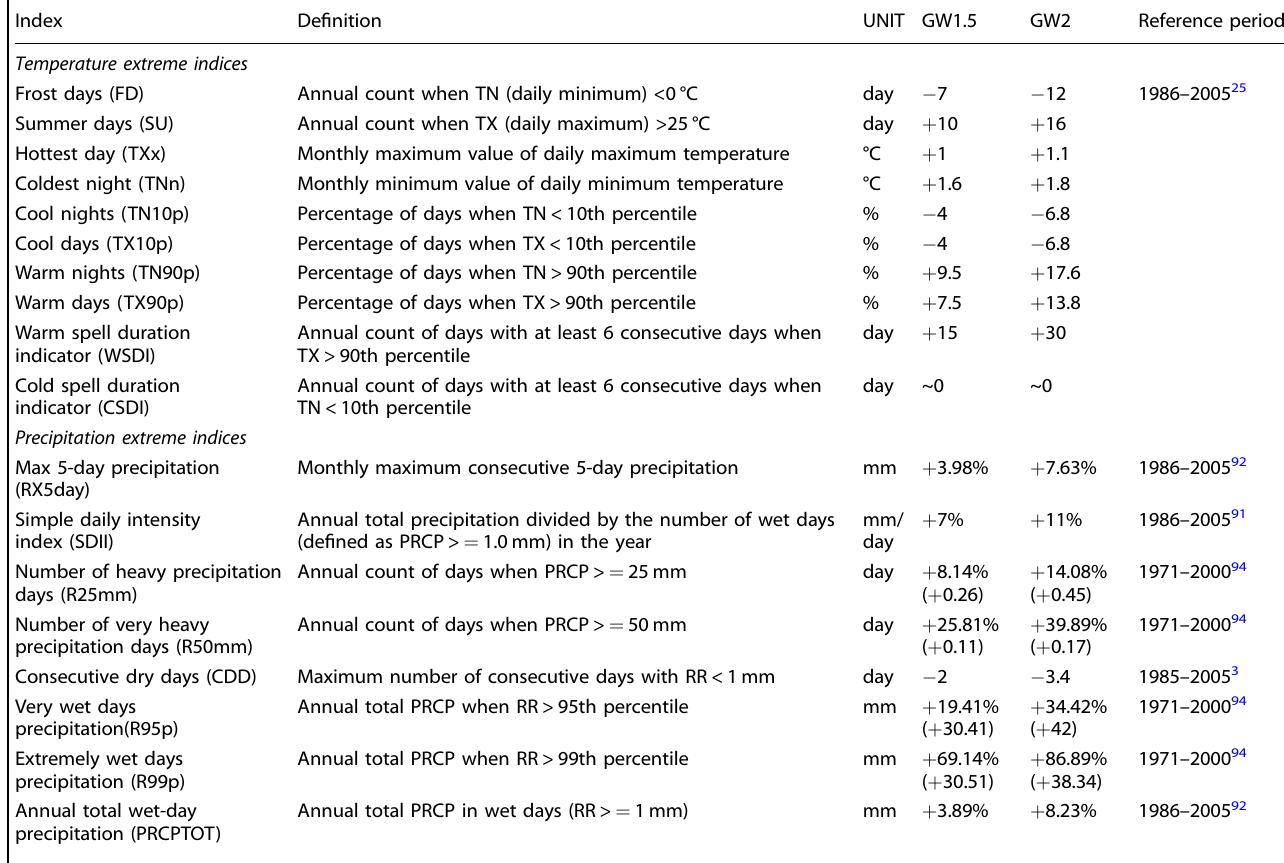
Table 2. Commonly used indices of climate extremes for temperature and precipitation and their predicted changes in China at GW1.5 and